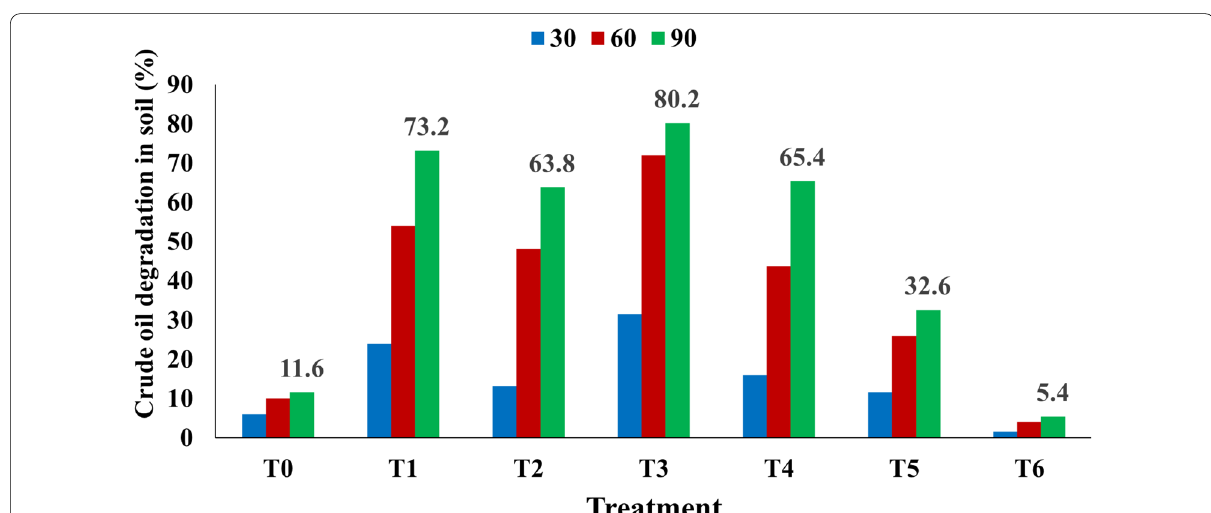
Fig. 7 The percent degradation of crude oil contaminated soil through various design treatments from T1–T6 for 90